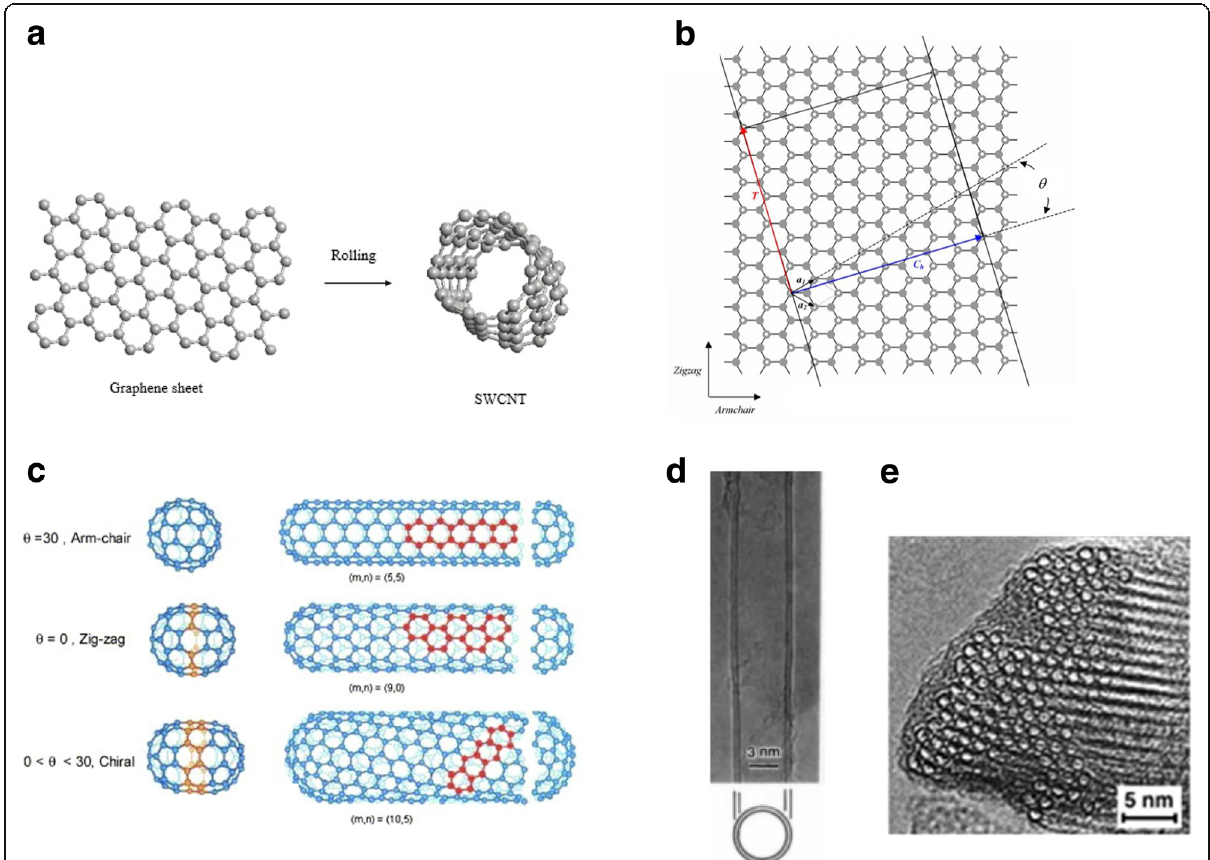
Fig. 1 a Formation of SWCNT by rolling a single layer of graphite. b Illustration of forming a CNT from an ideal graphite sheet. The two ends of the chiral vector C h are superimposed to create a nanotube with 1D lattice vector T and chiral angle ϴ . a 1 and a 2 are the primitive lattice vectors of 2D graphite (white dots denote lattice pints). The zigzag and armchair wrapping directions are also indicated. c Different types of CNTs based on their chirality. Adapted from [22]. d Electron micrograph image of a double-walled CNT with a diameter of 5.5 nm. Adapted from [78]. e Electron microscope images of a bundle of ~100 SWCNTs, packed in a triangular lattice. Adapted from